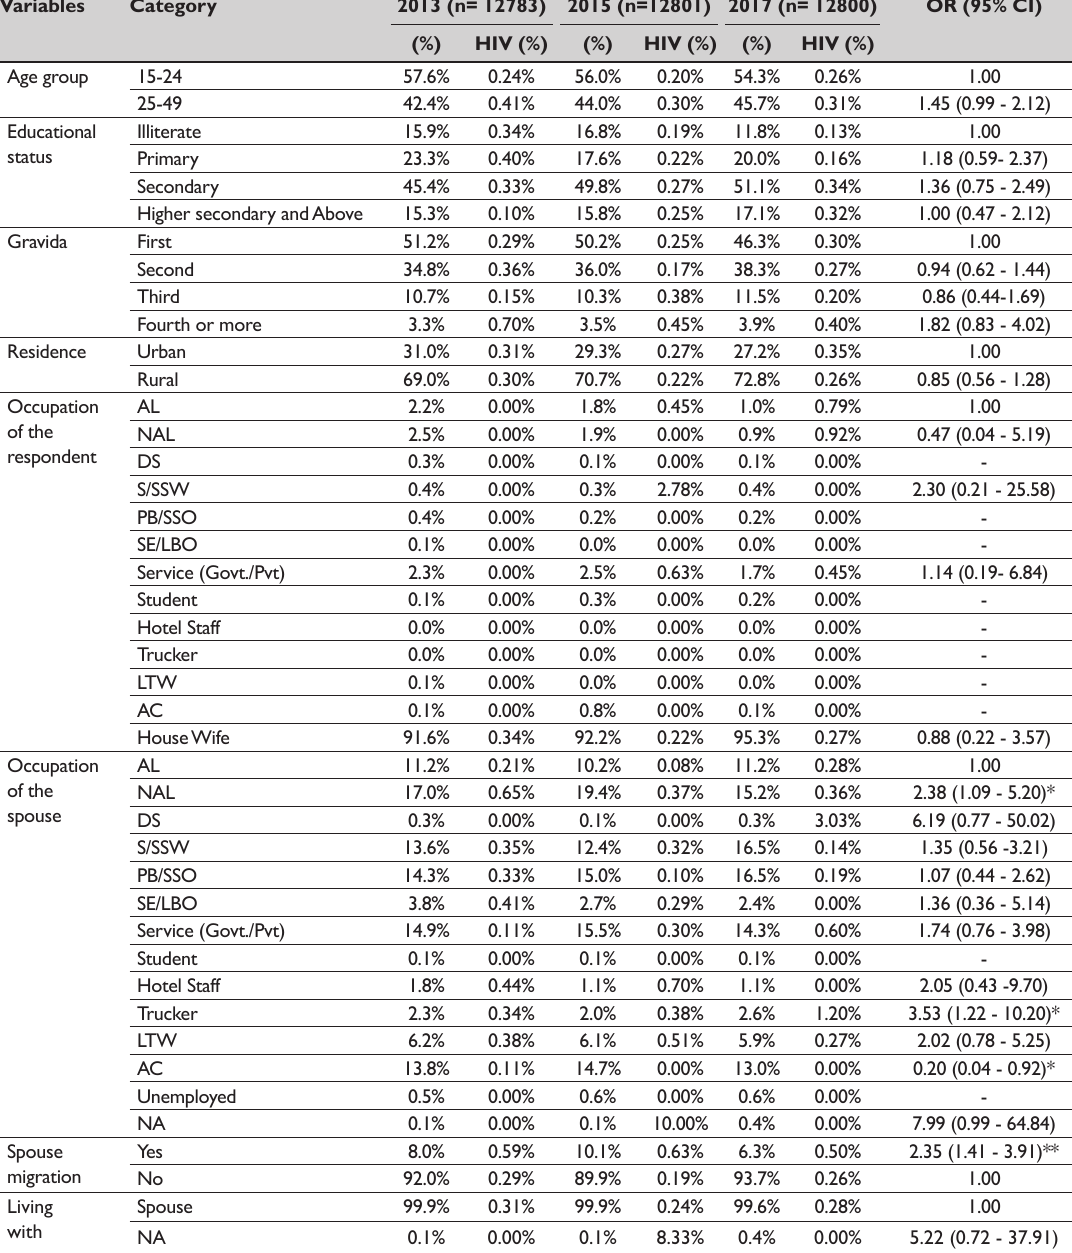
Table 1: Distribution and HIV Prevalence among Pregnant women in Odisha, last 3 rounds of the HIV Surveillance survey